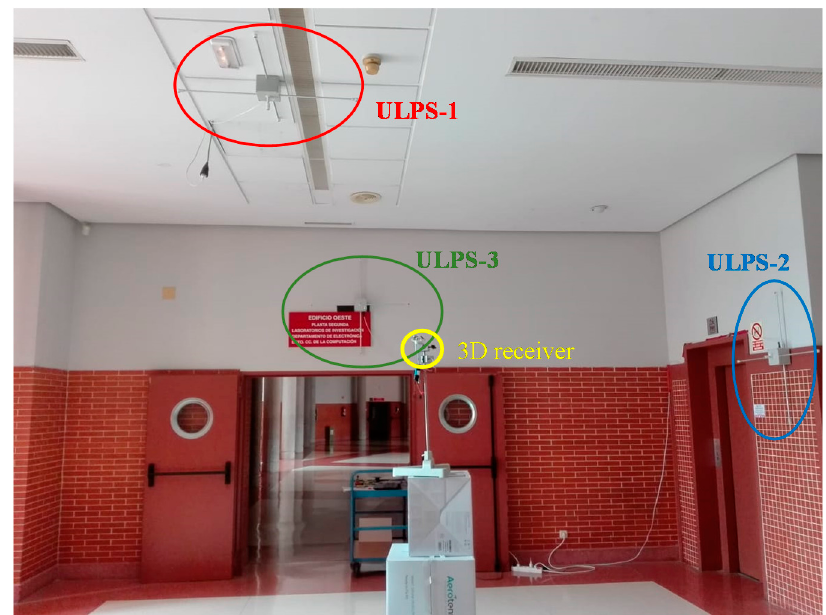
Figure 1. General view of the 3D scenario considered with three ULPS units installed on three perpendicular planes of the environment and a mobile receiver.